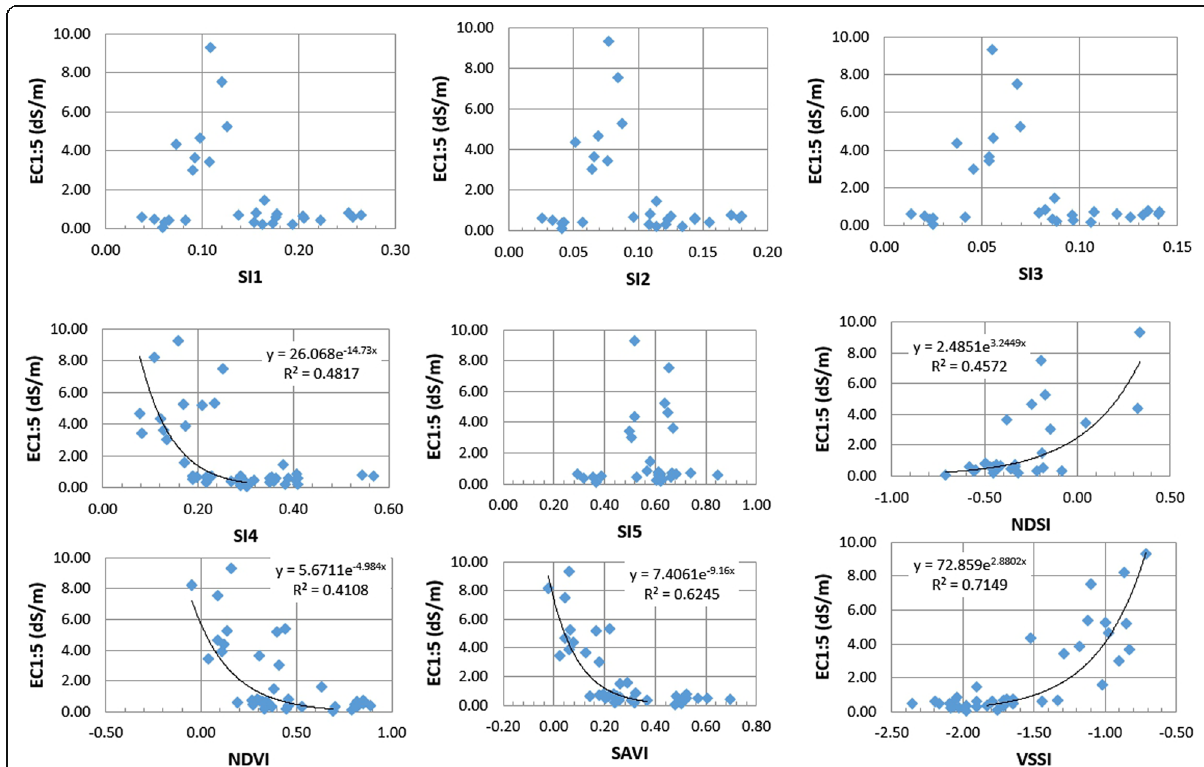
Fig. 8 Correlations between electrical conductivity (EC 1:5 ) and salinity indices derived from different bands of Landsat 8 OLI and environmental indices, including Normalized Difference Vegetation Index (NDVI), Soil Adjusted Vegetation Index (SAVI), and Vegetation Soil Salinity Index (VSSI)